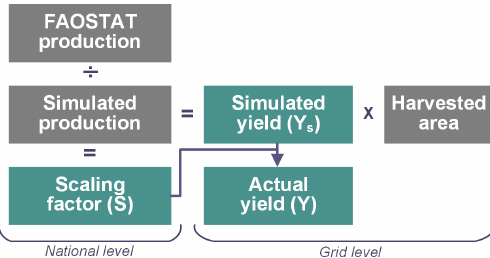
Figure 3. Calculation procedure of yield scaling factors at the na- tional